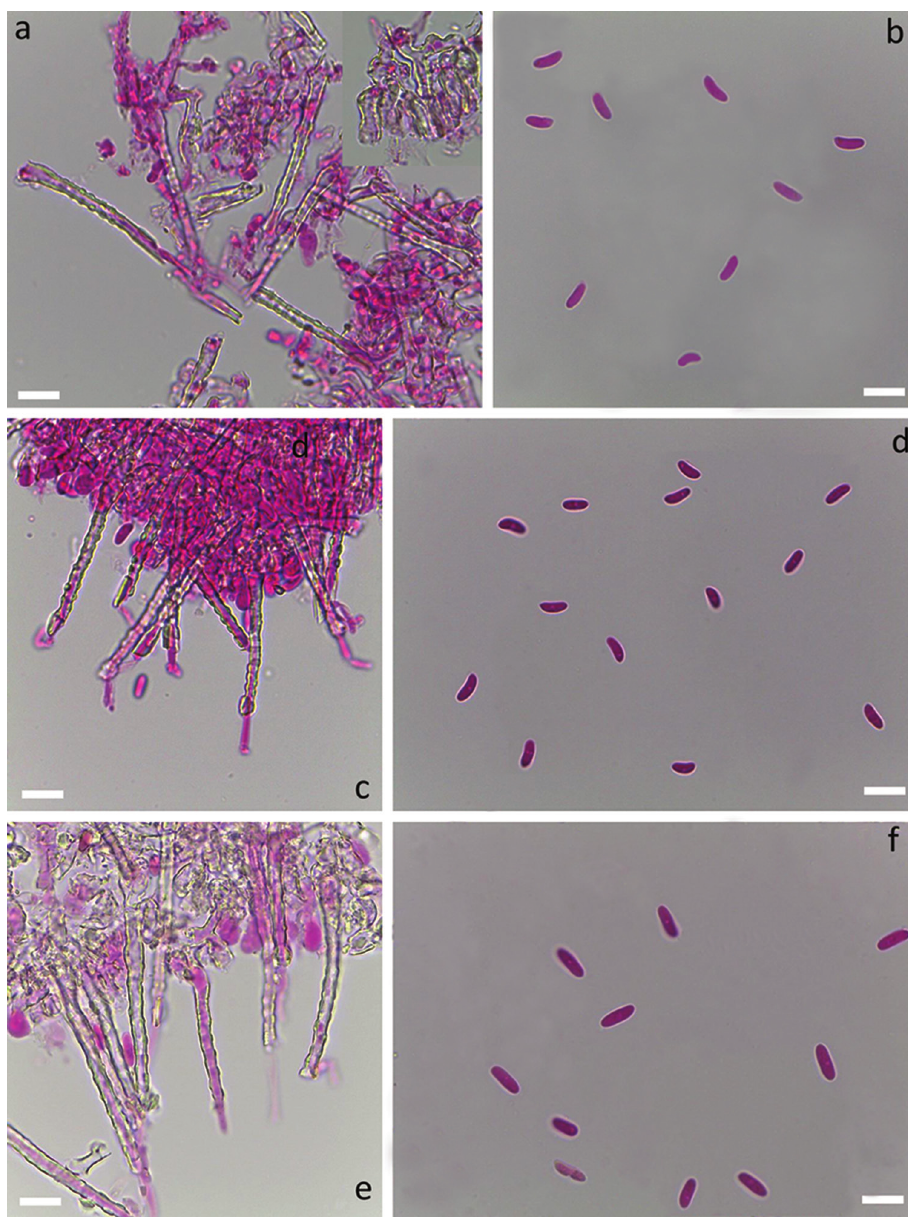
Figure 9. Species of Subulicystidium meridense morphotype. Subulicystidium meridense , holotype (TUB:FO 13761): a hymenium with crystalline encrustation and cystidia b basidiospores. S. meridense from own study (GB:KHL 11365): c cystidia in hymenium d basidiospores. Subulicystidium aff. meridense (GB:KHL 9561): e cystidia in hymenium f basidiospores. All preparations done in 3% aqueous solution of potassium hydroxide (KOH) mixed with 1% aqueous solution of Phloxine. All scale bars equal 10